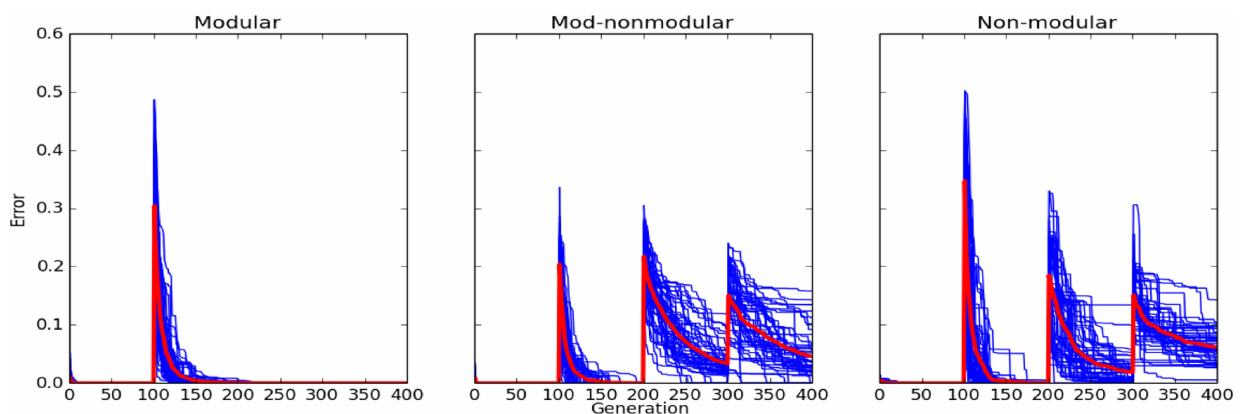
FIGURE 5 | Errors of controllers evolved for the M robot (left column), MNM robot (middle column), and the NM robot (right column) in fixed epoch training (Experiment 1 as described in Section 2) . New environment regimes occurred every 100 generations. Robots were evolved along the diagonal of the environment space meaning the order presented to the robot was AA , BB , AB , and BA . Each blue curve corresponds to an individual evolutionary run: it reports, at each generation, the controller with the lowest error in the population at that time. The red curve reports the average of these runs.